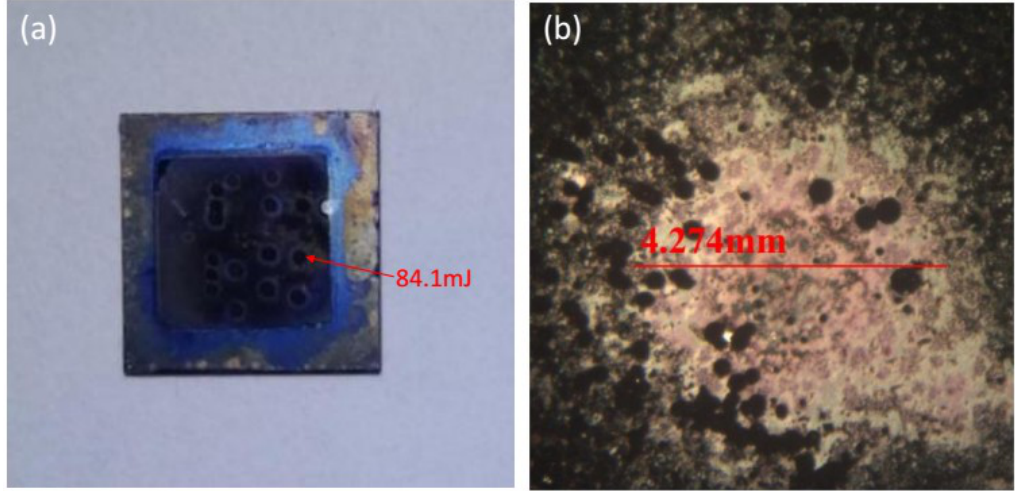
Figure 16. The appearance of the film after laser ignition: ( a ) physical photo; ( b ) optical microscope photo (32 times) .